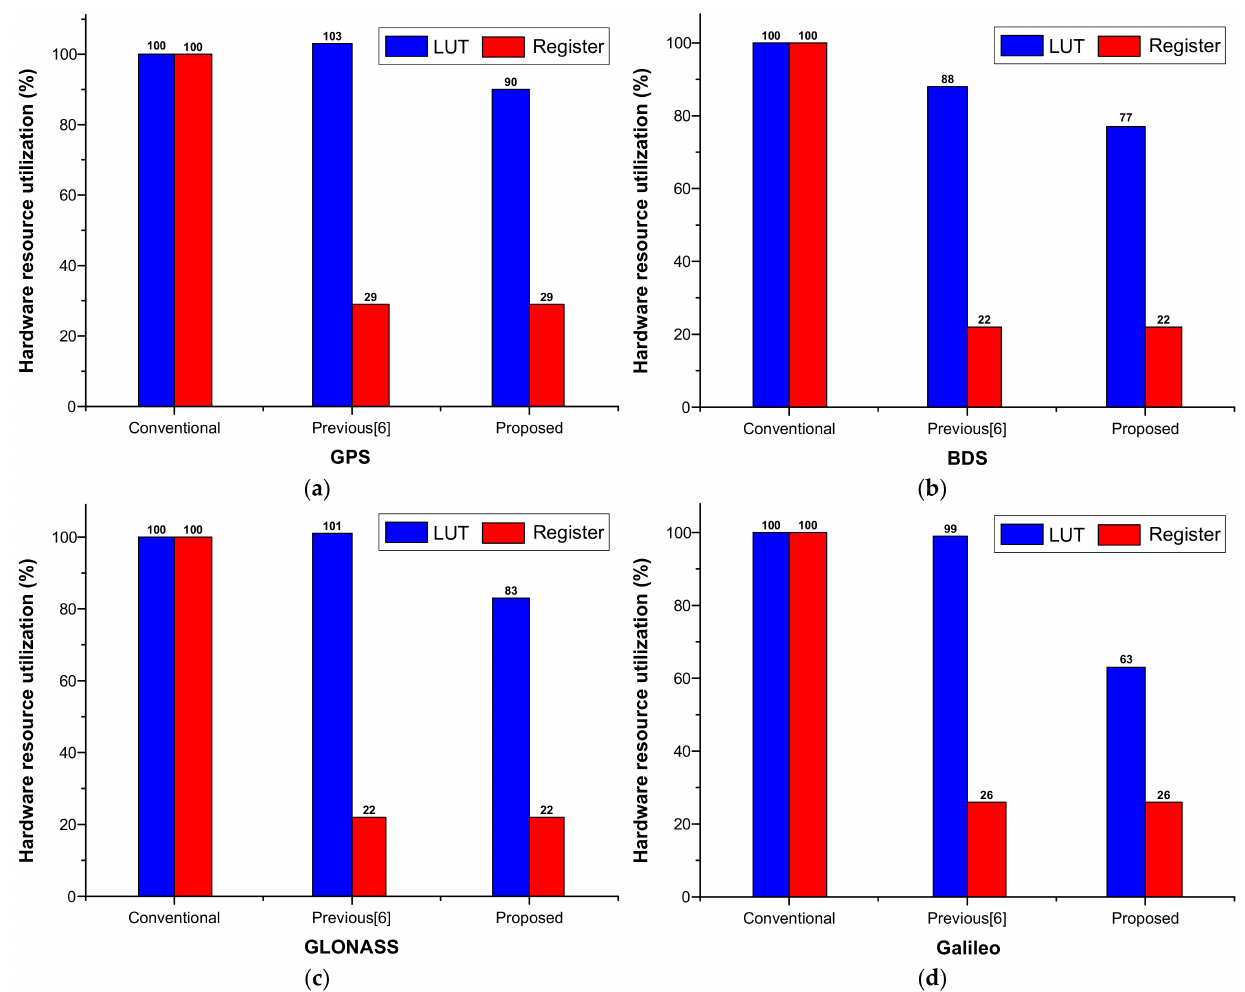
Figure 6. Hardware resource utilization comparison of the proposed multi-frequency code generator for each GNSS. ( a ) GPS. ( b ) BDS. ( c ) GLONASS. ( d )